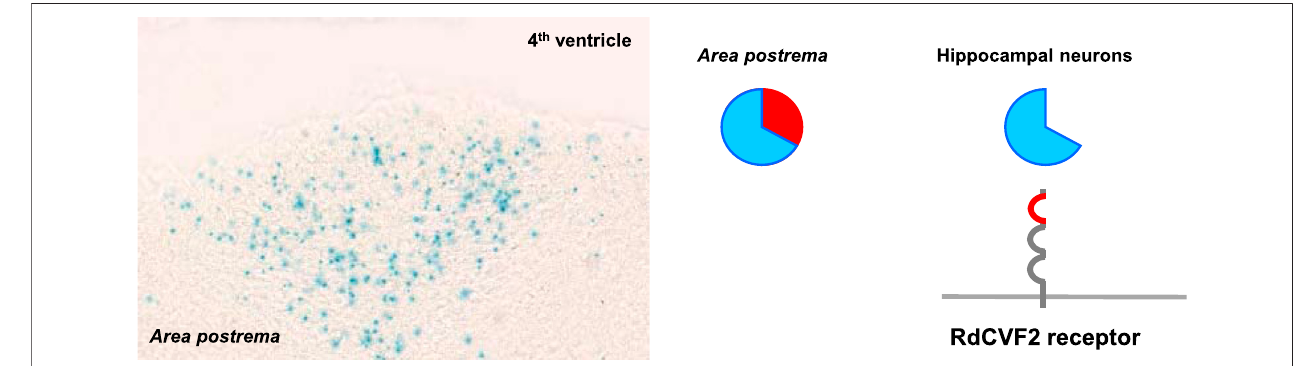
FIGURE 3 | Metabolic and redox signaling of the nucleoredoxin-like two gene in the brain. Cells of the area postrema expressing the Nxnl2 gene secret RdCVF2 that binds to its cell surface receptor on hippocampal